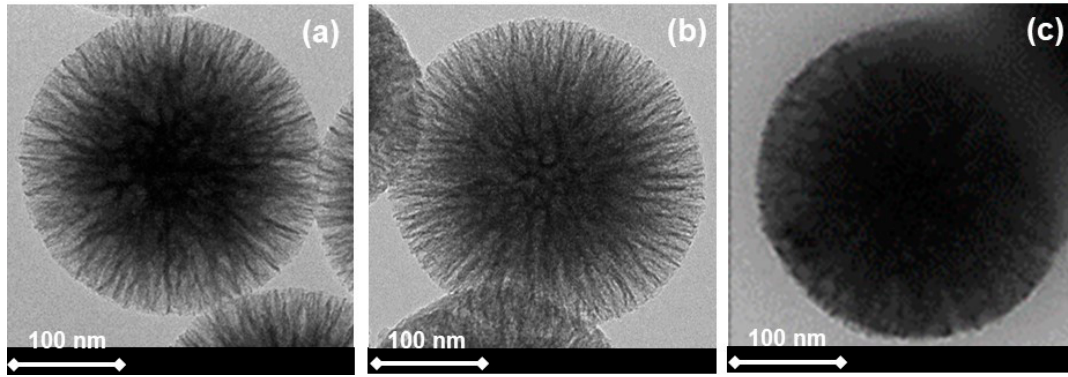
Figure 1. TEM images of wrinkled silica nanoparticles (WSNs) before ( a ) and after calcination ( b ), and β -glucosidase (BG)/WSNs ( c ).